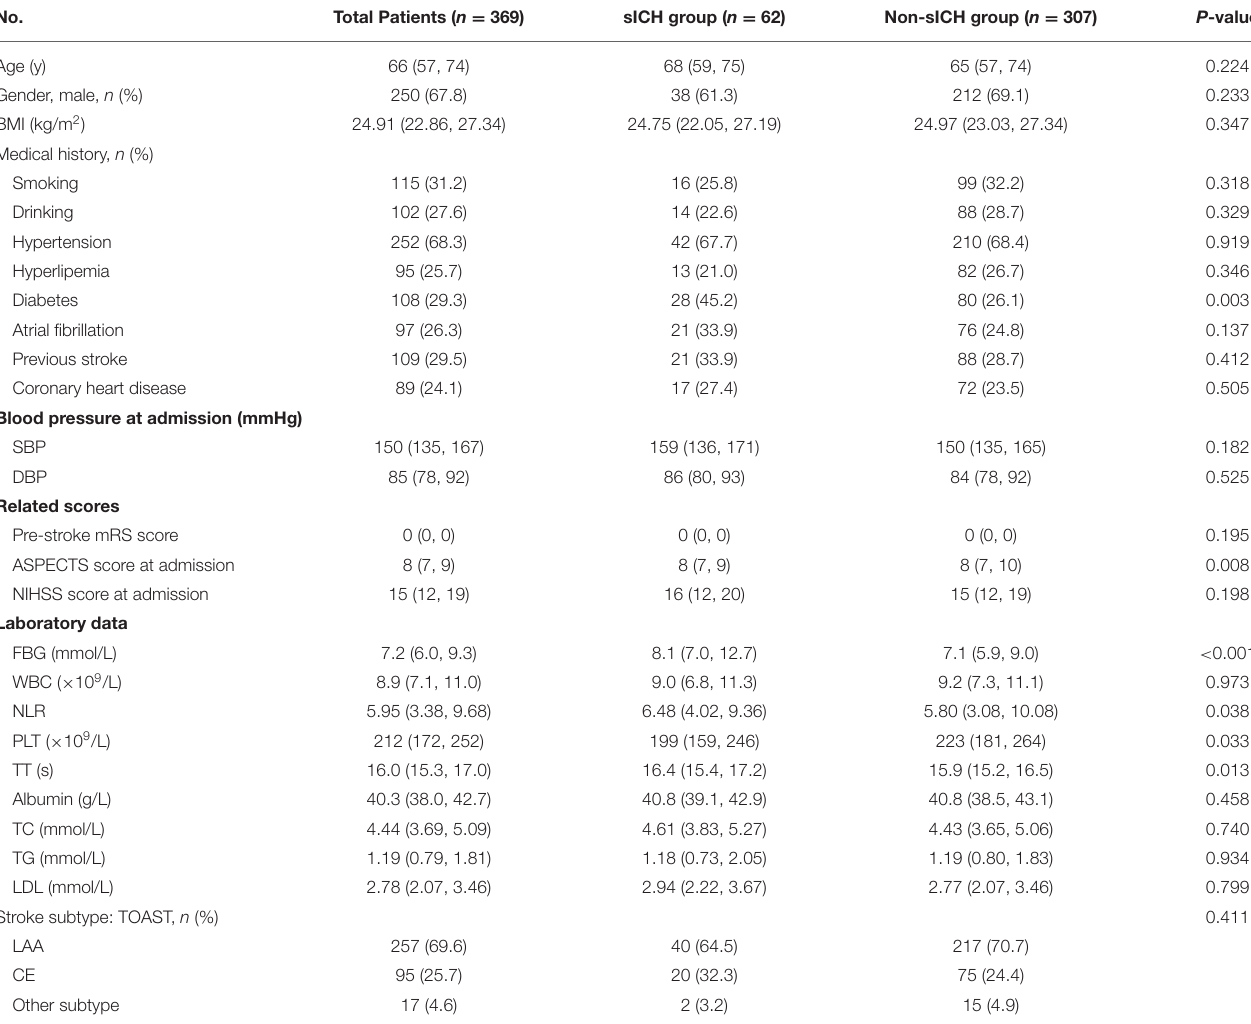
TABLE 1 | Baseline characteristics of patients with sICH and without